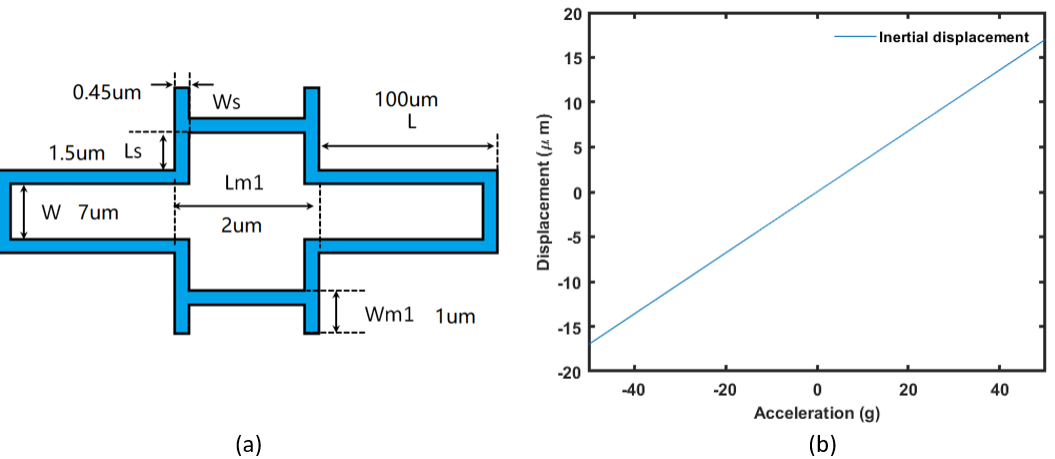
Figure 14. The basic unit (one period) of the spring design ( a ) and the corresponding inertial displacement ( b